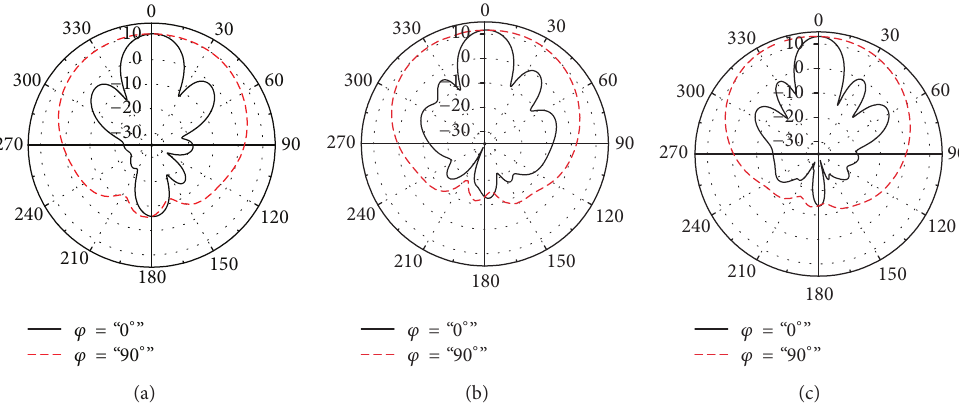
Figure 11: Radiation pattern of the IMF-CBSA array without feeding network obtained in the simulation: (a) 18 GHz; (b) 22 GHz; (c) 26 GHz.